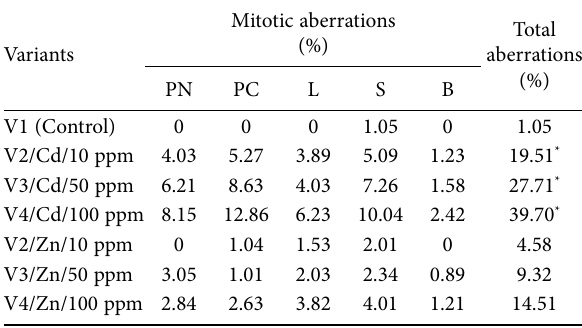
Table 3. Type and percentage of mitotic aberrations induced by cadmium and zinc on the meristematic roots to Ocimum basilicum L.